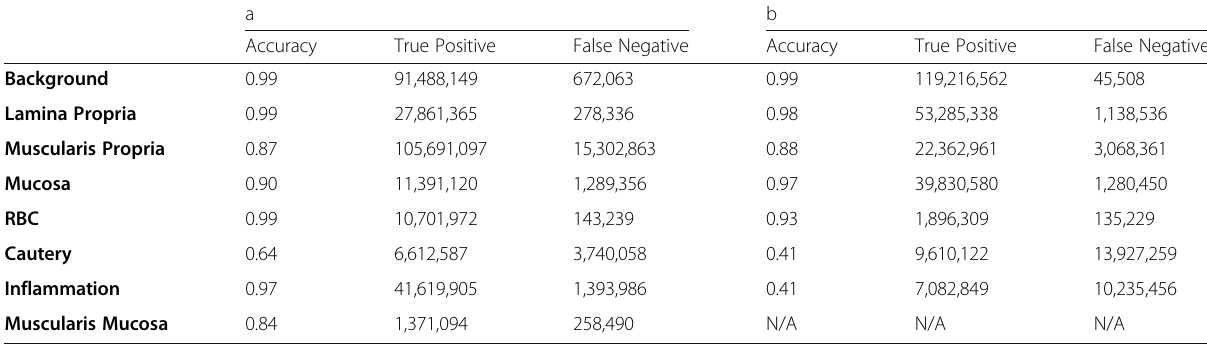
Table 3 Results (pixel level accuracy) on 12 layered U-Net architecture initialized using He Normal. a) Results on the validation slides in dataset S1. b) Results on the test slides in dataset